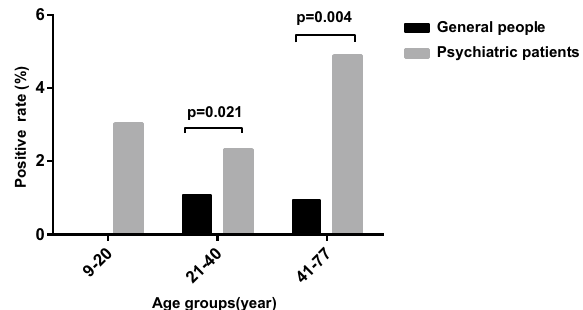
Figure 1. Comparison of anti- Toxoplasma antibody-positivity rates between psychiatric patients and the general population in different age groups. Compared with the general population, psychiatric patients in